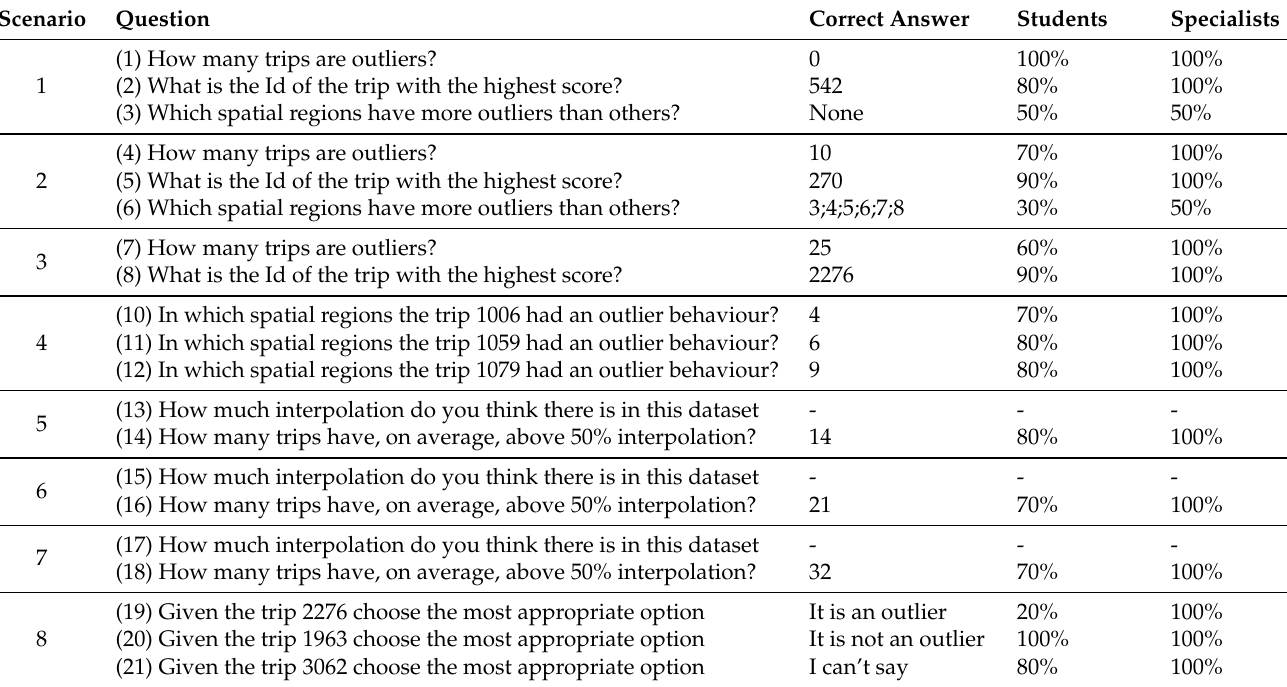
Table 1. User responses (students and specialists) for all questions asked in the